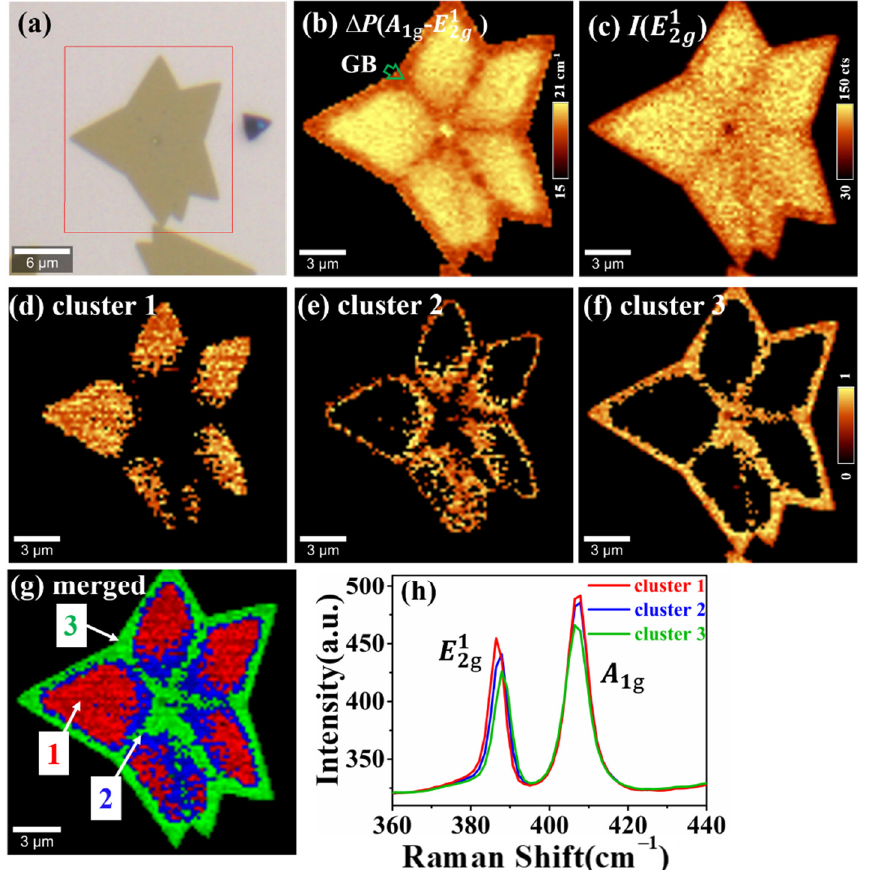
Figure 2. K-means clustering Raman analysis of inhomogeneity in monolayer polycrystalline CVD- growth MoS 2 sample. ( a ) Optical image of monolayer polycrystalline MoS 2 on a Si/SiO 2 wafer. ( b ) Raman images of peak position differences between 𝐴 (cid:2869)(cid:3034) and 𝐸 (cid:2870)(cid:3034)(cid:2869) modes. ( c ) Raman image of the absolute intensity of 𝐸 (cid:2870)(cid:3034)(cid:2869) mode. ( d – f ) Three clustered maps obtained by k-means clustering method with the correlated characteristic spectra. ( g ) The merged image of all clusters: Cluster 1 (red), cluster 2 (blue), and cluster 3 (green). ( h ) Raman spectra of these three clusters.